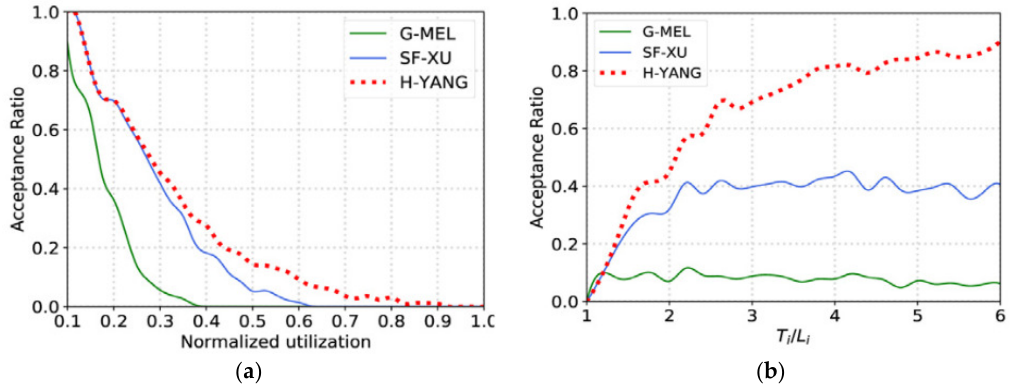
Figure 11. Comparison of different synthetic workload; ( a ) Standardized utilization, ( b ) Tensity.